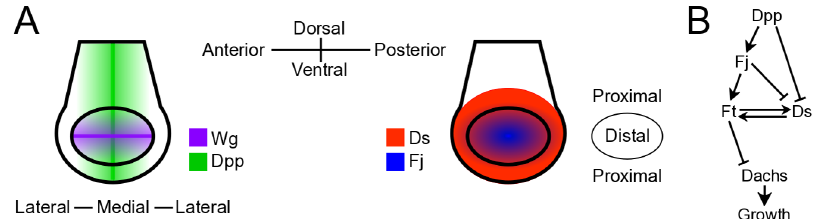
Fig 1. Visualization of components of the Ft pathway. (A) The approximate expressionpatterns of the morphogens Decapentaplegic(Dpp, green) and Wingless (Wg, purple), the protocadherin Dachsous (Ds, red), and the Golgi kinase Four-jointed(Fj, blue) in a late third-instarwing disc. The inner oval (distal region) corresponds to the wing pouchor wing primordium, while the tissue outsidethe oval (proximal region)will form the wing’s hinge in the adult. Dpp and Wg are produced along the anterior-posterior and dorsal-ventral boundariesrespectively,and form gradedconcentration profiles along the axes orthogonalto the source boundaries[4, 13]. (B) The Fat (Ft) pathway. IncreasedDpp activity is in generalassociatedwith more Fj and less Ds expression(althoughthe relationship is not directly proportional and is likely affected by other factors such as Vg [5]). Ft and Ds form bondswith one another betweenadjacent cells. Phosphorylationby Fj makes Ft more likely and Ds less likely to form bonds. Dachs localizesto cell-cellinterfaces where there is less bound Ft. IncreasedDachs localization is associatedwith faster cell